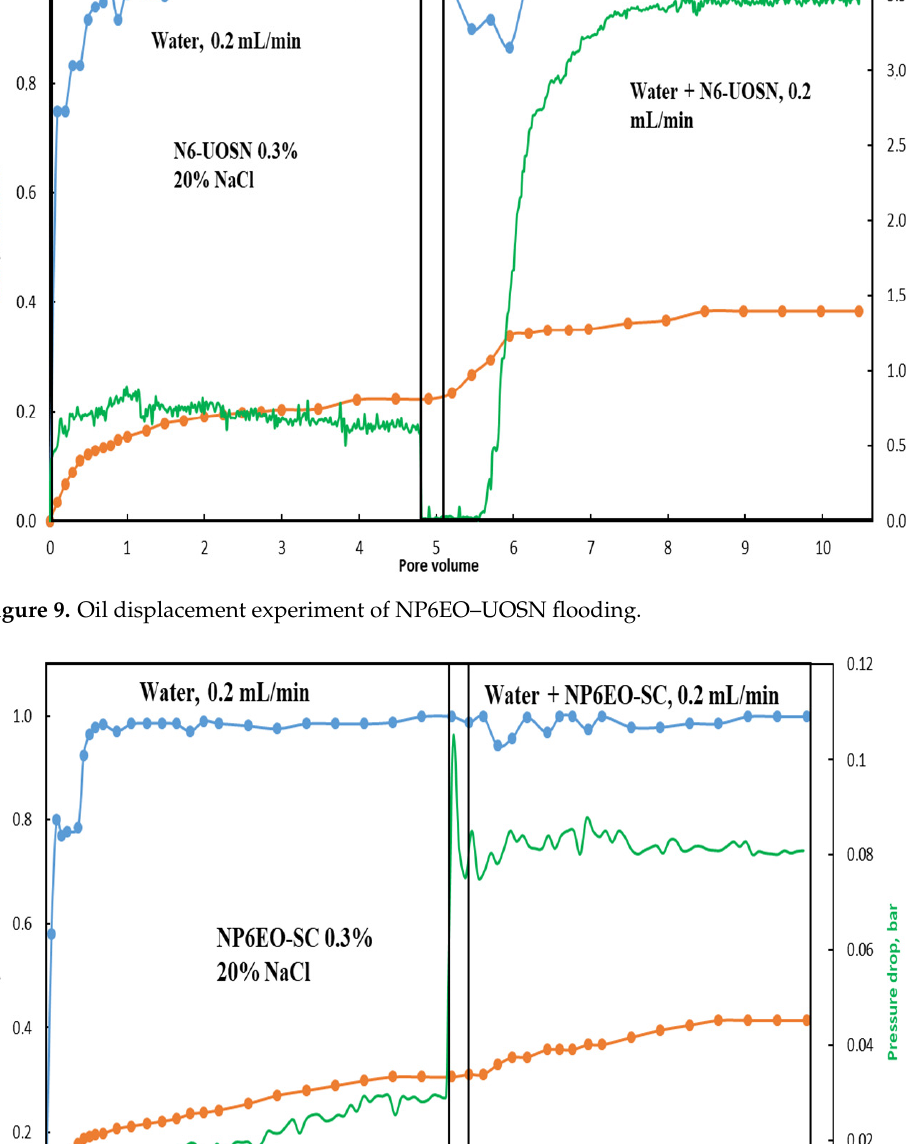
Figure 10. Oil displacement experiment of NP6EO–SC flooding.